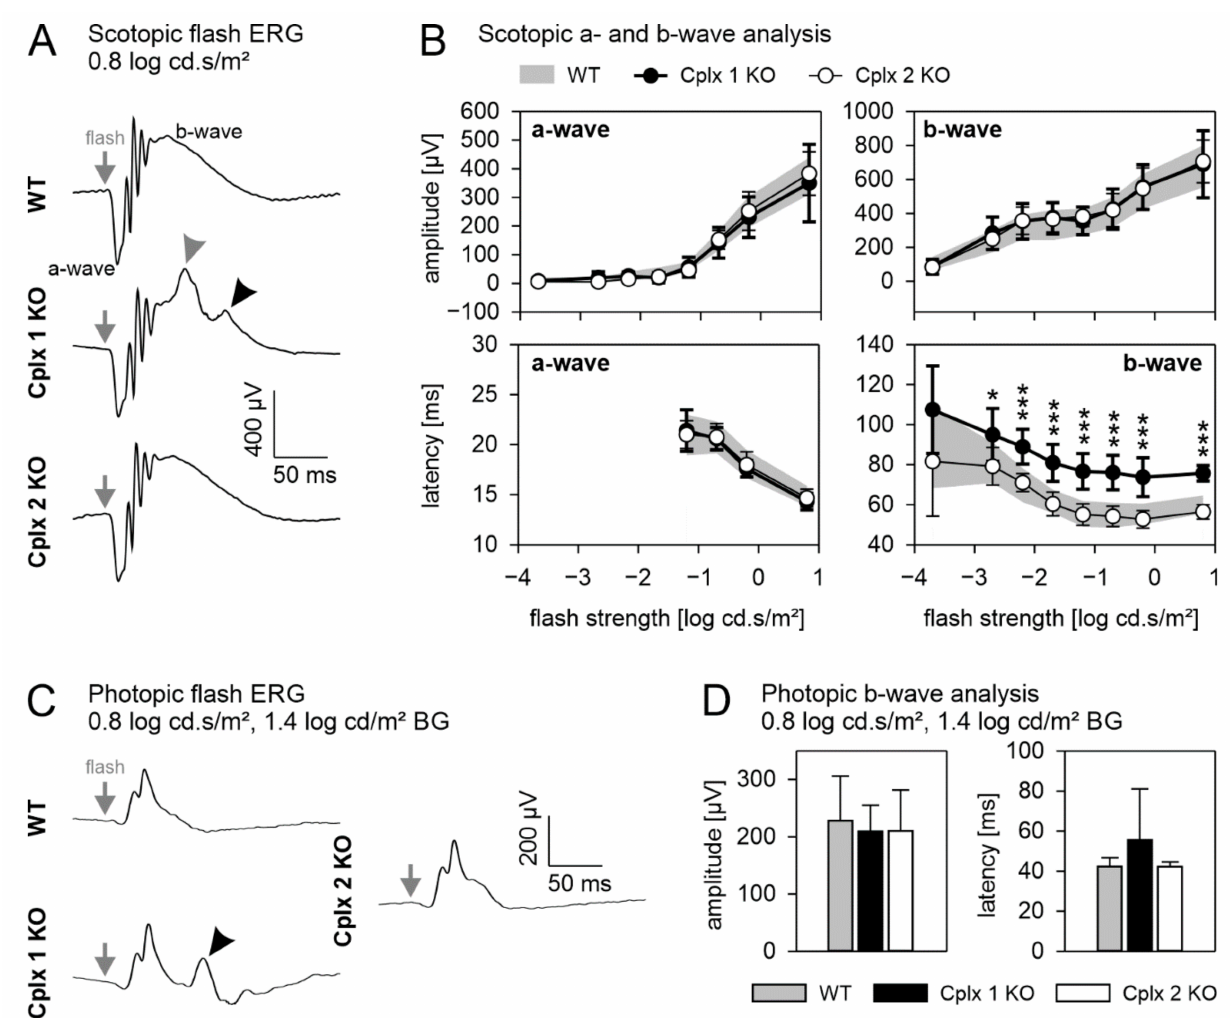
Figure 5. Flash electroretinographic recordings (ERG) of wildtype (WT) and Cplx 1 and Cplx 2 knockout (KO) mice. ( A ) Comparison of the mean ERG responses to a scotopic flash of 0.8 log cd × s/m 2 between WT and Cplx 1 and Cplx 2 KO mice. Gray arrows indicate flash onset. The black arrowhead highlights the abnormal second peak on the descending part of the b-wave; the gray arrowhead highlights the additional shoulder riding on the peak of the b-wave in Cplx 1 KO mice. ( B ) Amplitude and latency of the scotopic a- and b-wave. WT range is indicated by gray area; Cplx 1 KO, closed symbols; Cplx 2 KO, open symbols. Values are shown as the mean ± SD. Statistical significance is indicated by black asterisks (* p < 0.05; *** p < 0.001; two-sided t -test). Bonferroni-correction factor for multiple testing was 8 for all p -values. ( C ) Comparison of the mean ERG responses to a photopic flash of 0.8 log cd × s/m 2 upon a white background of 1.4 log cd/m 2 between the WT and Cplx 1 and Cplx 2 KO mice. Gray arrows indicate flash onset. The black arrowhead highlights the abnormal second peak on the descending part of the b-wave in Cplx 1 KO mice. ( D ) Amplitude and latency of the photopic b-wave for WT (gray bar), Cplx 1 KO (black bar) and Cplx 2 KO (white bar). Values are shown as the mean ± SD. Number of animals for scotopic and photopic ERG (WT, n = 16; Cplx 1 KO n = 7; Cplx 2 KO, n =